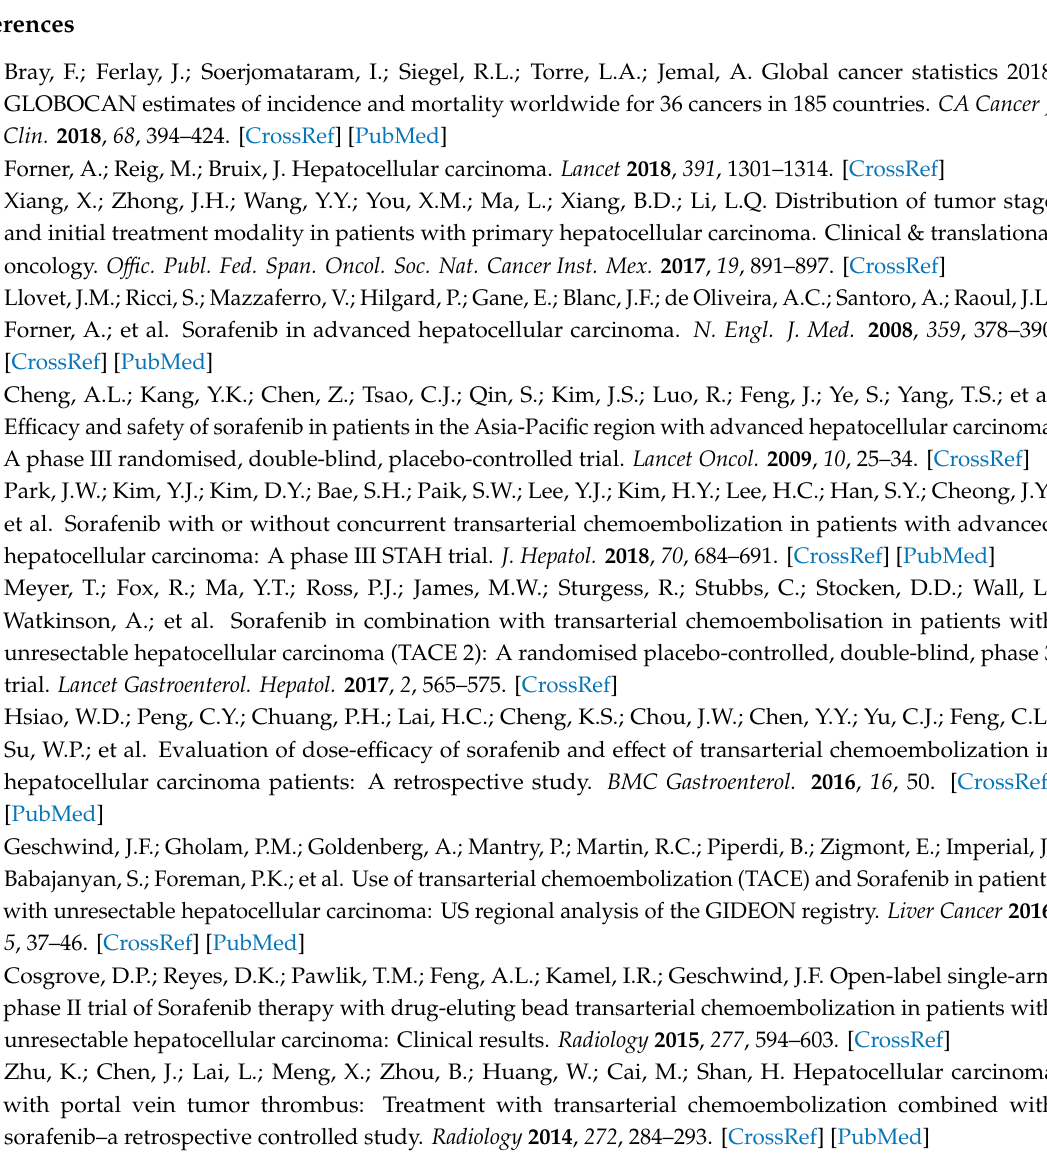
Table S1: STROBE Statement—Checklist of items that should be included in reports of cohort